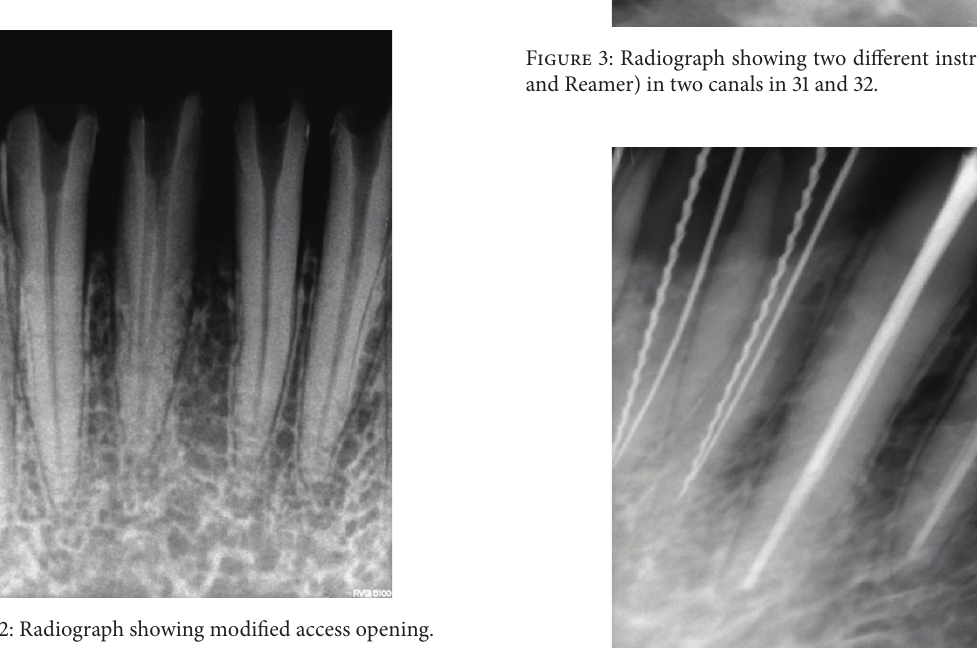
Figure 1: Preoperative radiograph.